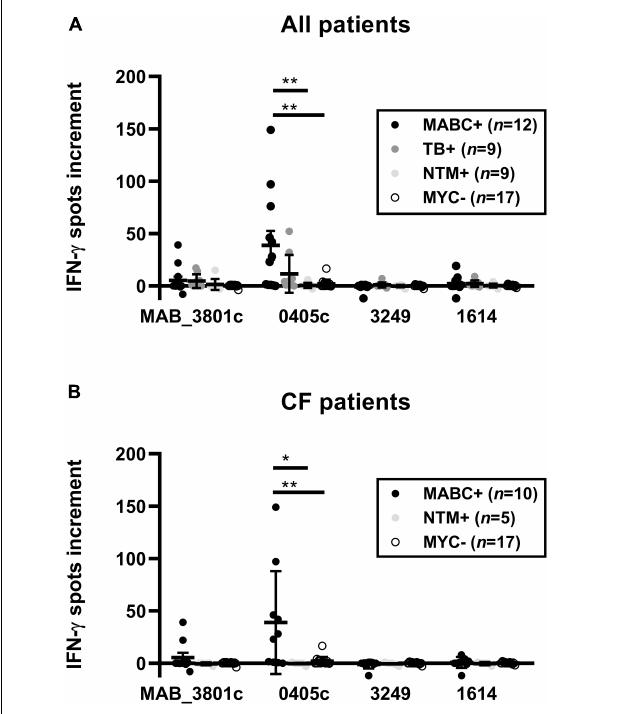
FIGURE 4 | PBMC of patients with M. abscessus (MABC) infection, subjects with cystic fibrosis (CF) without mycobacterial infection (MYC-), subjects with NTM infection other than MABC (NTM), and subjects with tuberculosis (TB) were stimulated with the four M. abscessus proteins MAB_3801c, MAB_0405c, MAB_3249, and MAB_1614, and IFN- γ production was determined by ELISpot. We analyzed cellular responses in all 47 patients (A) and separately in 32 patients with cystic fibrosis (CF) (B) , using the optimized cell culture conditions, as defined in Section “Materials and Methods.” Data are indicated as mean and standard error of the mean (SEM). The four patient groups were compared by one-way ANOVA. Cellular in vitro responses are given as spots increment, i.e., MABC protein stimulated minus negative control. * p < 0.05; ** p <